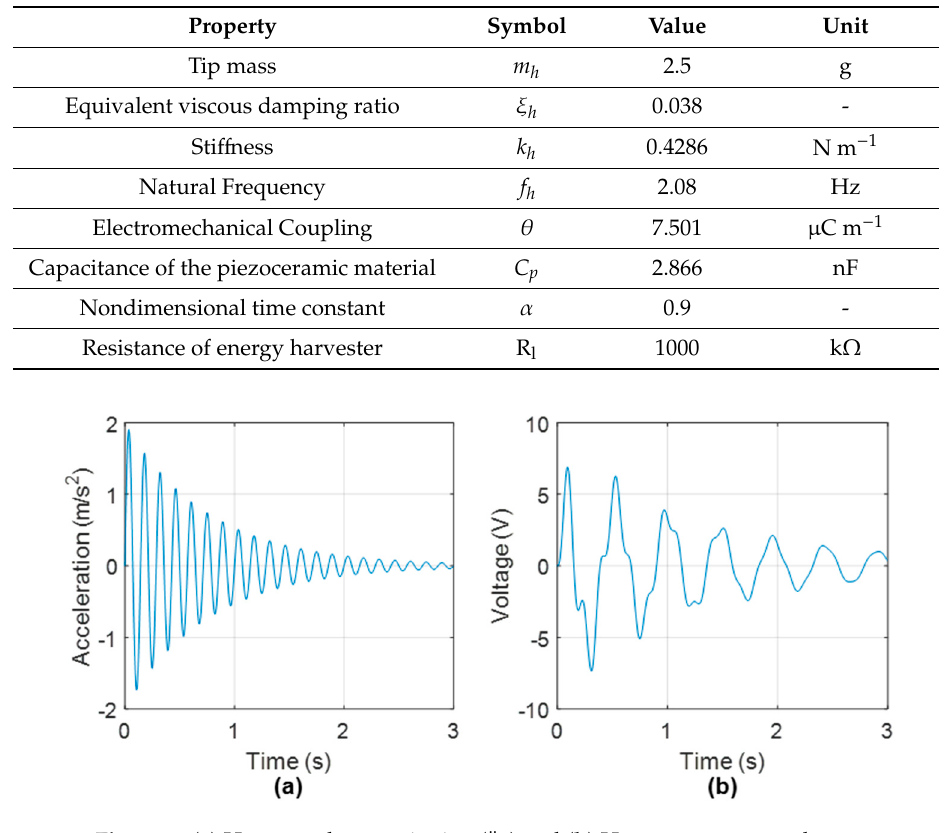
Figure 2. ( a ) Harvester base excitation ( ÿ 𝒃 ) and ( b ) Harvester output voltage.